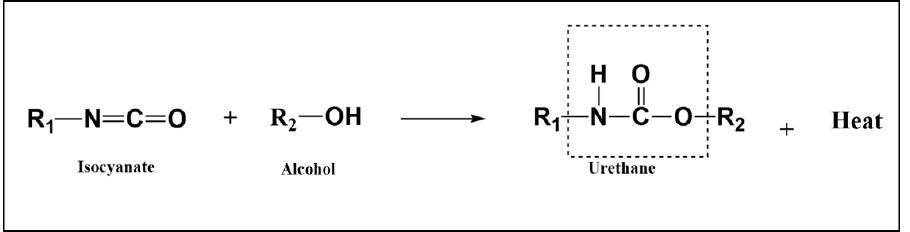
Figure 1. Classical reaction to synthesize urethane linkage adapted from [8].